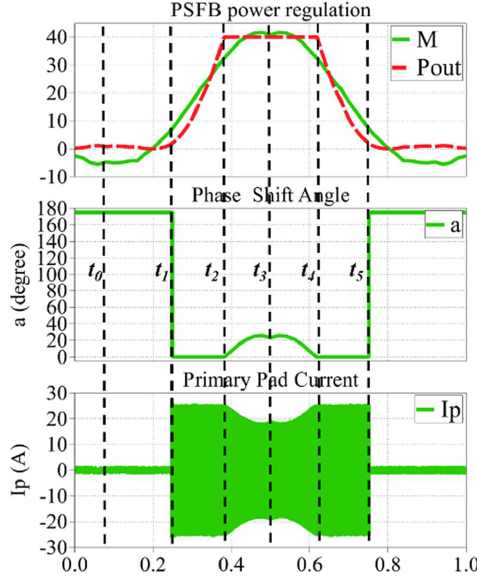
Figure 11. Phase shift full bridge (PSFB) power control process.